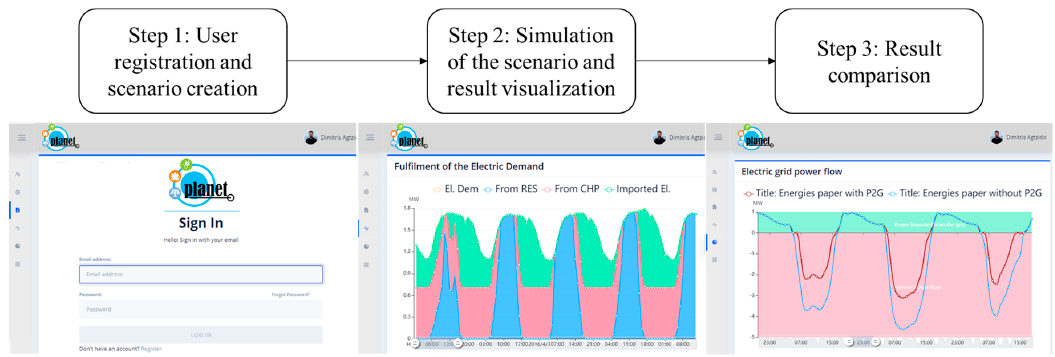
Figure 3. PLANET DSS UI utilization steps.